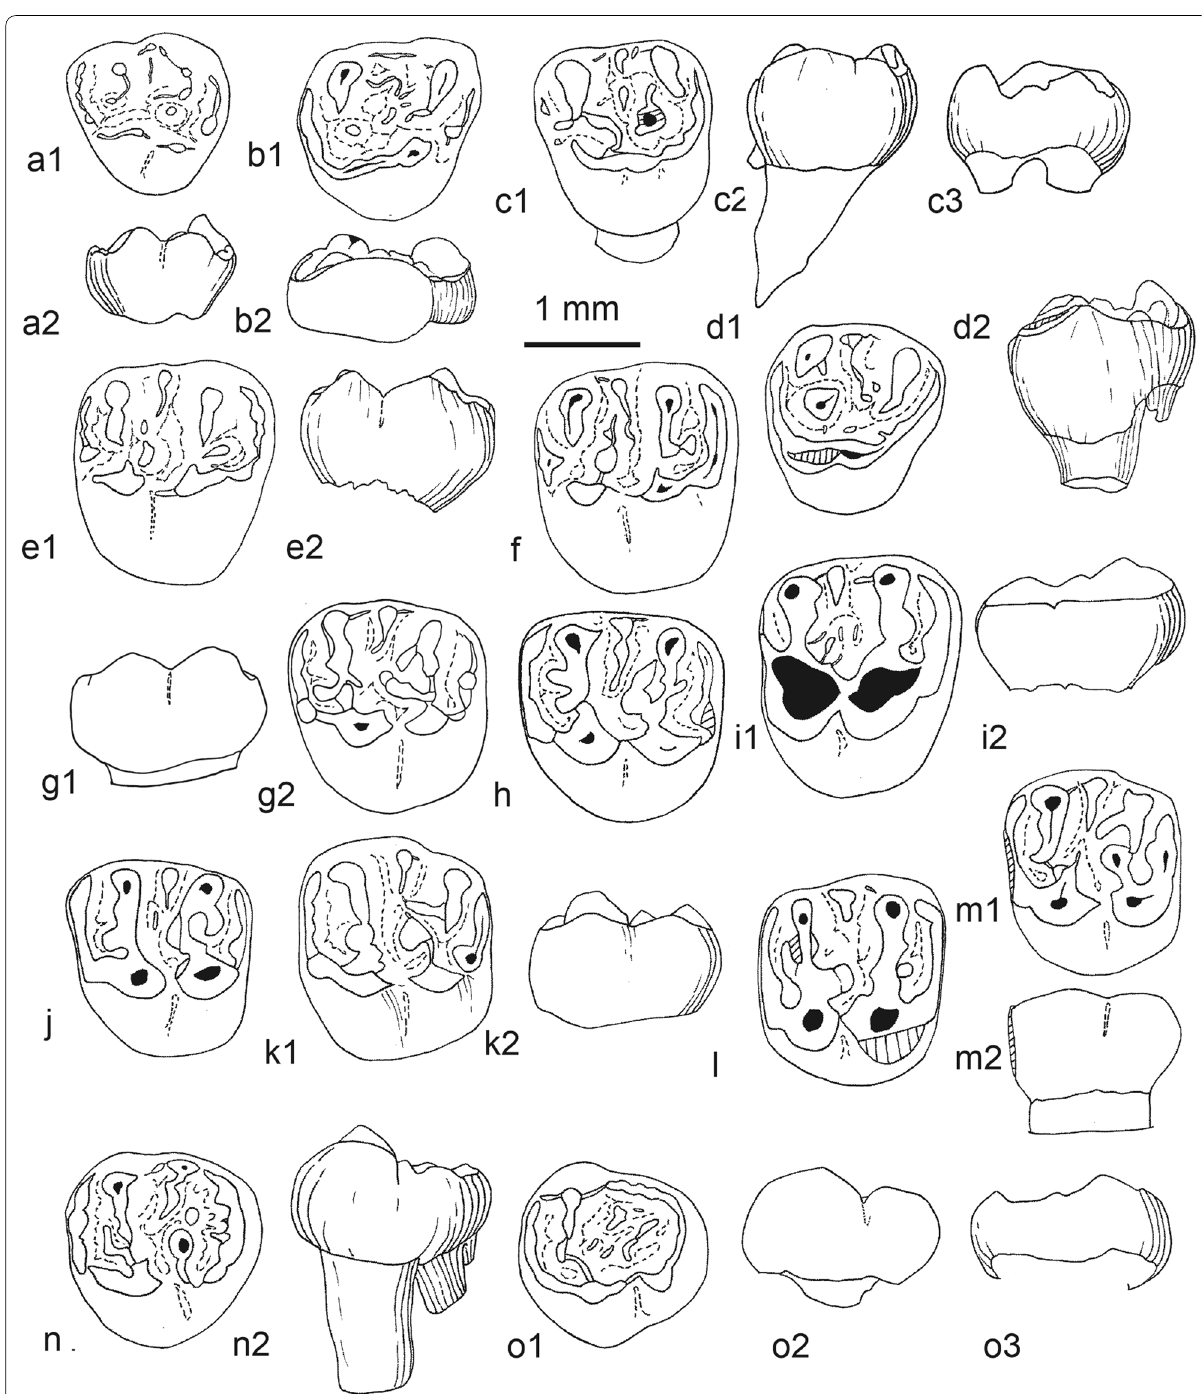
Fig. 23 Upper teeth of Protadelomys lugdunensis Hartenberger, 1969 from Laprade (Quercy). a LAP 191, left DP4; a1, occlusal view; a2, lingual aspect. b LAP 192, right P4; b1, occlusal view; b2, lingual aspect. c : LAP 235, left P4; c1, occlusal view; c2: lingual aspect; c3: buccal aspect. d LAP 84, left P4; d1, occlusal view; d2: lingual aspect. e LAP 200, right M1; e1, occlusal view; e2: lingual aspect. f LAP 224, right M1, occlusal view. g LAP 205, left M1 or 2; g1, lingual aspect; g2, occlusal view. h LAP 83, left M1; occlusal view. i LAP 198, right M1, worn; i1, occlusal view; i2: lingual aspect. j : LAP 85, left M1; occlusal view. k : LAP 88, left M2; k1, occlusal view; k2, lingual aspect. l: LAP 86, right M1–2; occlusal view. m : LAP 203, left M1–2; m1, occlusal view; m2, lingual aspect. n : LAP 206, left M3; n1, occlusal view; n2, lingual aspect. o : LAP 255, left M3; o1, occlusal view; o2, lingual aspect; o3, buccal aspect. Scale bar: 1